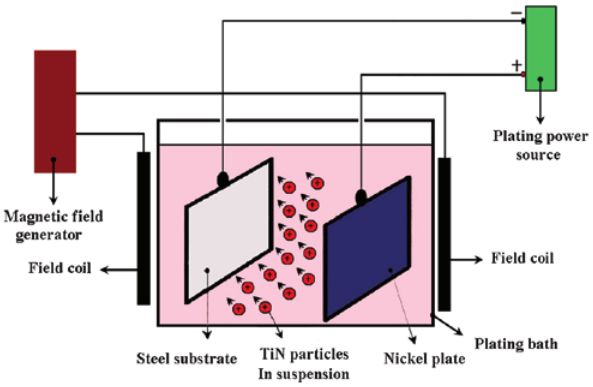
Figure 1: Schematic diagram of the electrodeposition device.